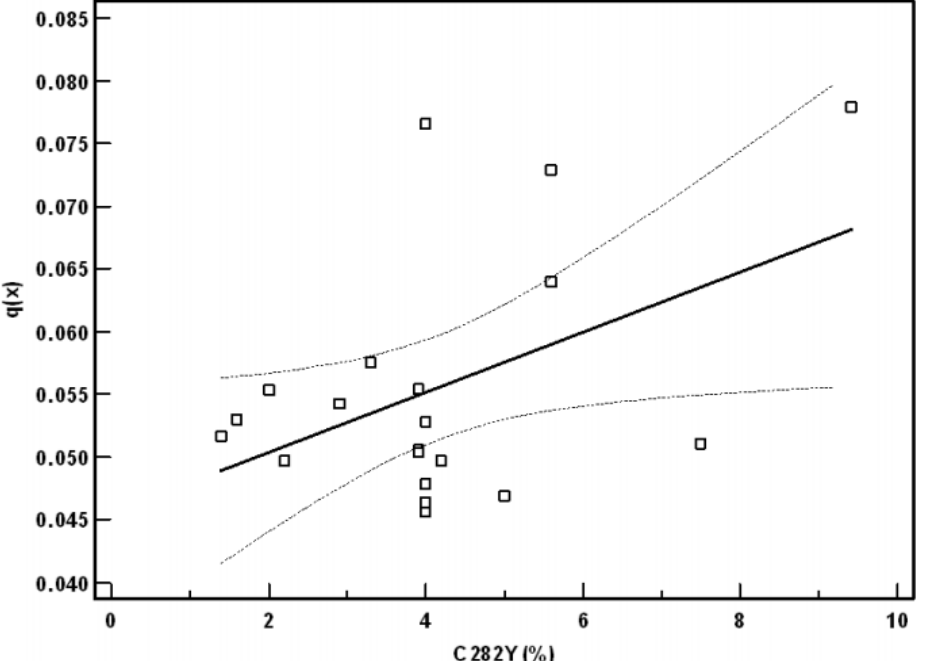
Figure 1. Mortality in 30–35 year old subjects in 1846 according to C282Y allele frequencies in a number of French departments. The Y -axis depicts the death probabilities q ( x ) for every age ( x ) computed for that period. The X -axis represents the C282Y allele frequency in the different